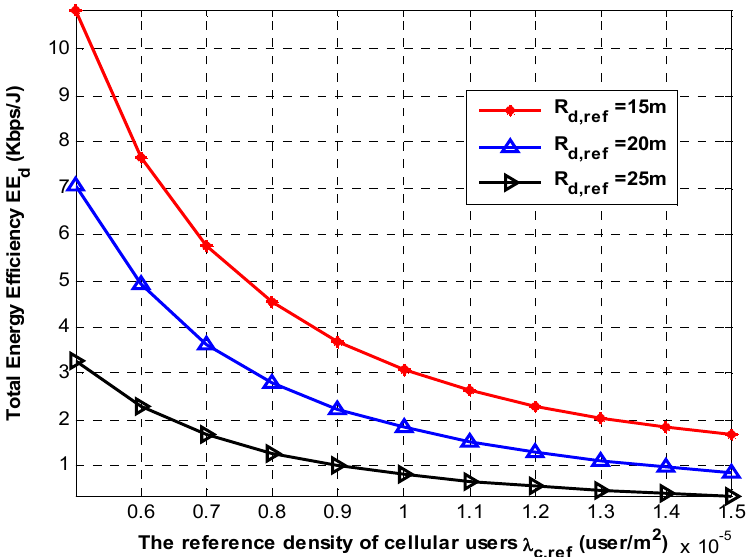
Figure 6. The energy efficiency of D2D users against the reference density of cellular users by using the modified derivative algorithm.